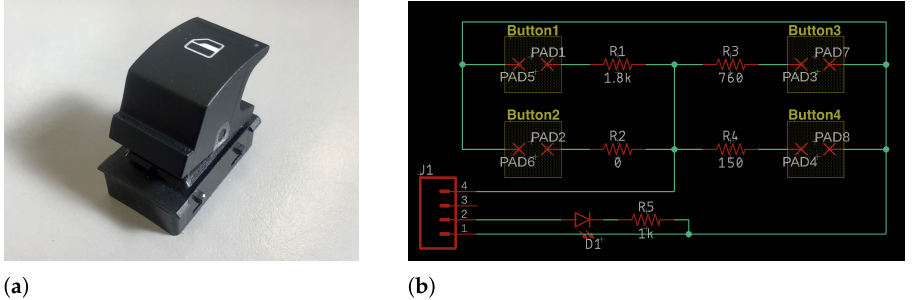
Figure 11. Passenger window pane elevator button in ( a ). The schematic of the electric button is shown in ( b ).